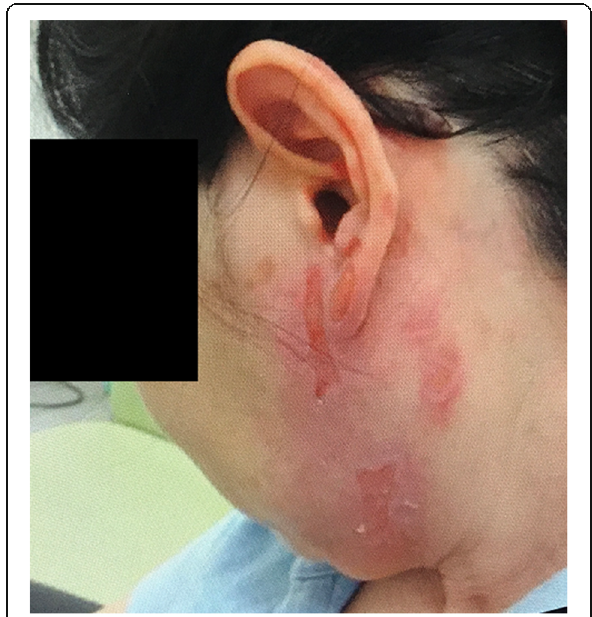
Fig. 1 Cutaneous findings of the left pinna and cheek. The rash of herpes zoster had improved and only pigmentation was remained. Ulcers due to scratching were